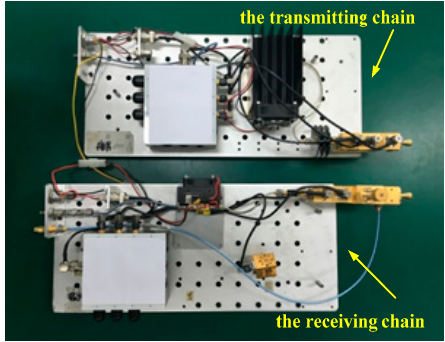
Figure 3. The transmitting and receiving front ‐ ends of the 0.22 THz radar system.